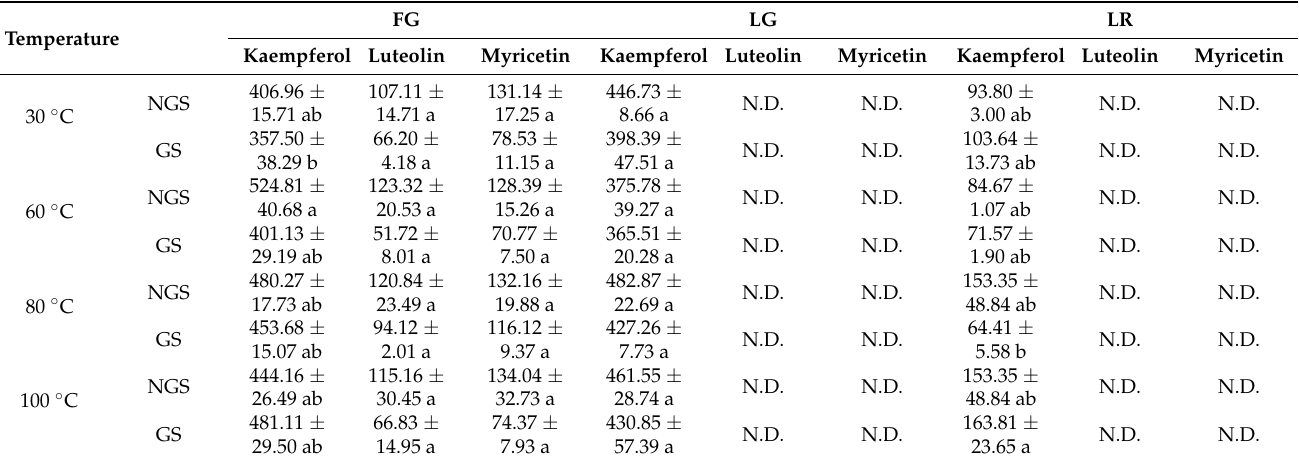
Table 2. The effects of thermal processing on flavonoid content ( µ g/g DW) variations in three cultivars of whole lentil NGS and